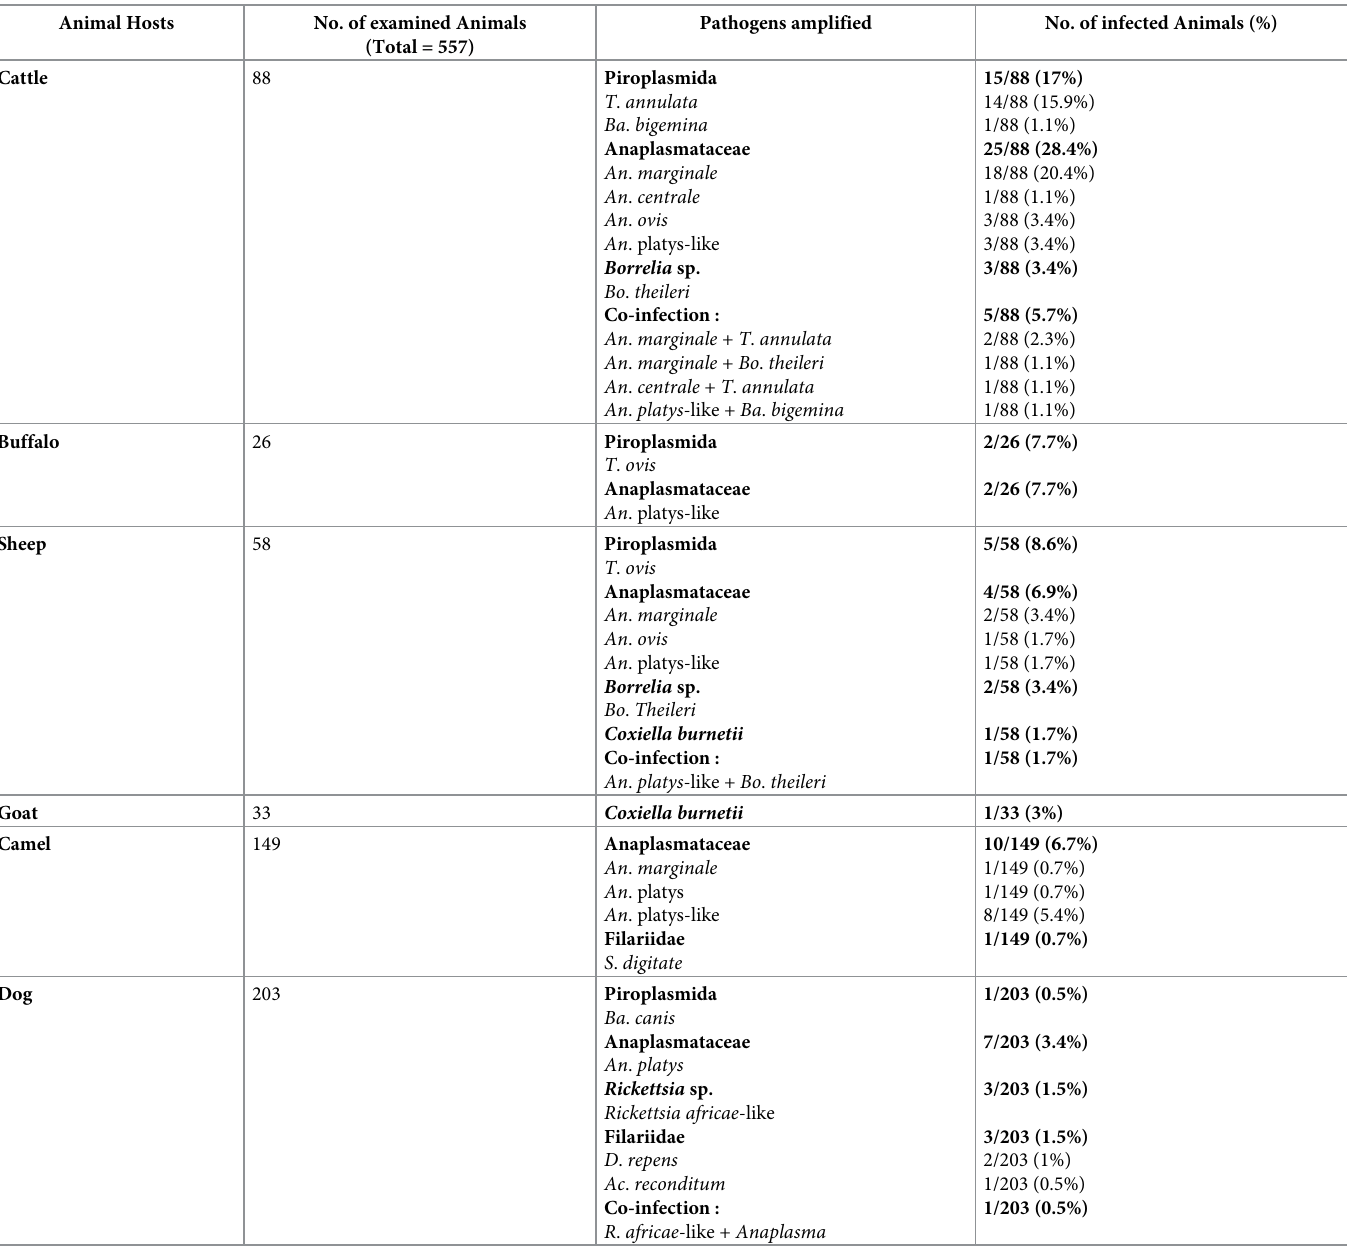
Table 3. The prevalence of pathogens in animals by PCR. Animal Hosts No. of examined Animals (Total =